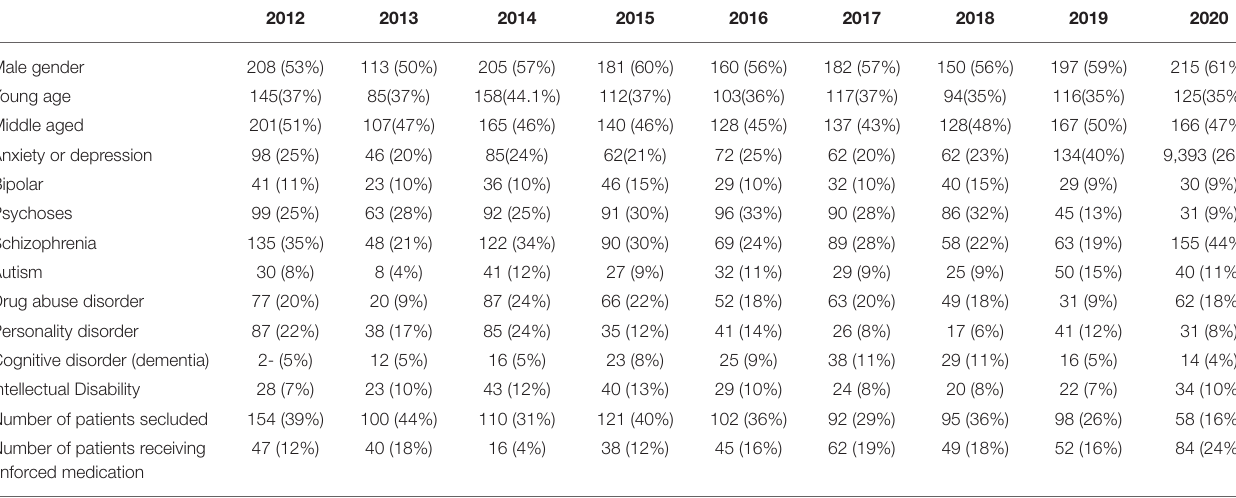
TABLE 4 | Patient compilation: seclusion and medication in involuntary admitted patients over